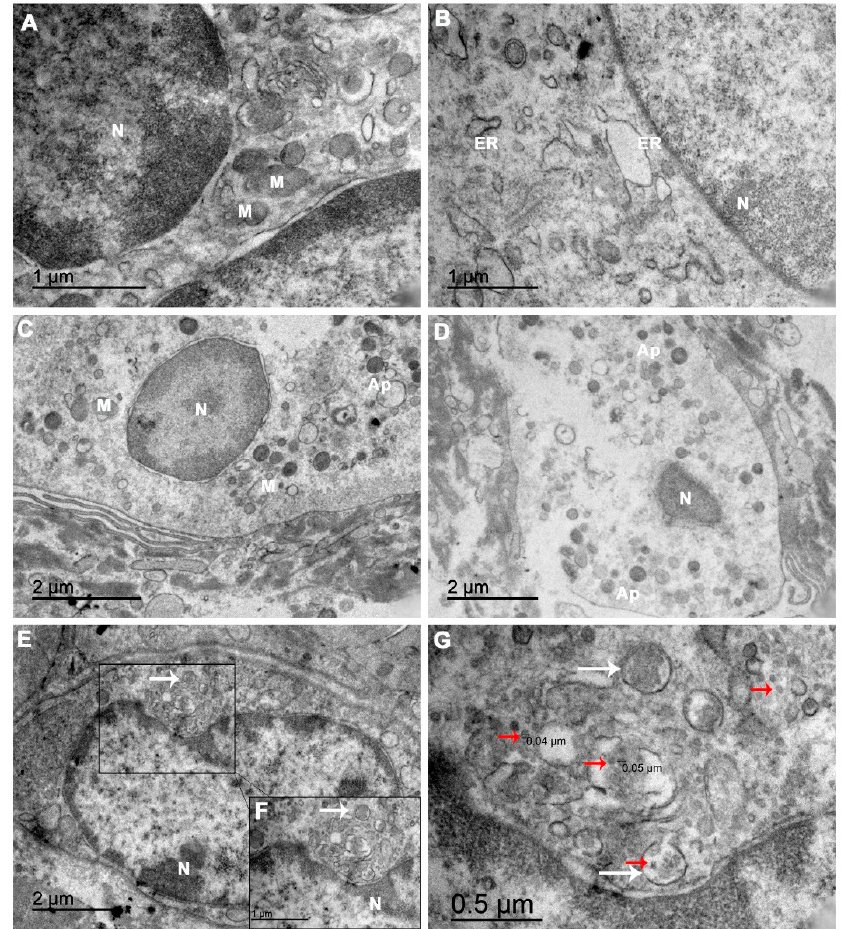
Figure 4. An electron microscopy analysis of the ultrathin abortion material sections showed damaged organelles and virus-like particles: ( A ) Electron micrographs of CHIKV-infected cells showing dispersed chromatin in the nuclei (N), mitochondria (M) with fewer cristae and ( B ) endoplasmic reticulum (ER) exhibiting dilated cisterns. ( C ) A decidual cell presenting a rarefied cytoplasm with an absence of organelles and starting to produce apoptotic bodies (Ap). ( D ) A decidual cell in apoptosis. ( E , F ) A cell with vesicles surrounding a cluster of virions in the cytoplasm (white arrows). ( G ) In the same field, at a higher magnitude, these CHIKV virus-like particles (red arrows) are located near a ruptured ER. The scale bar indicates that the particles are approximately 40–50 nm in size, consistent with the CHIKV.